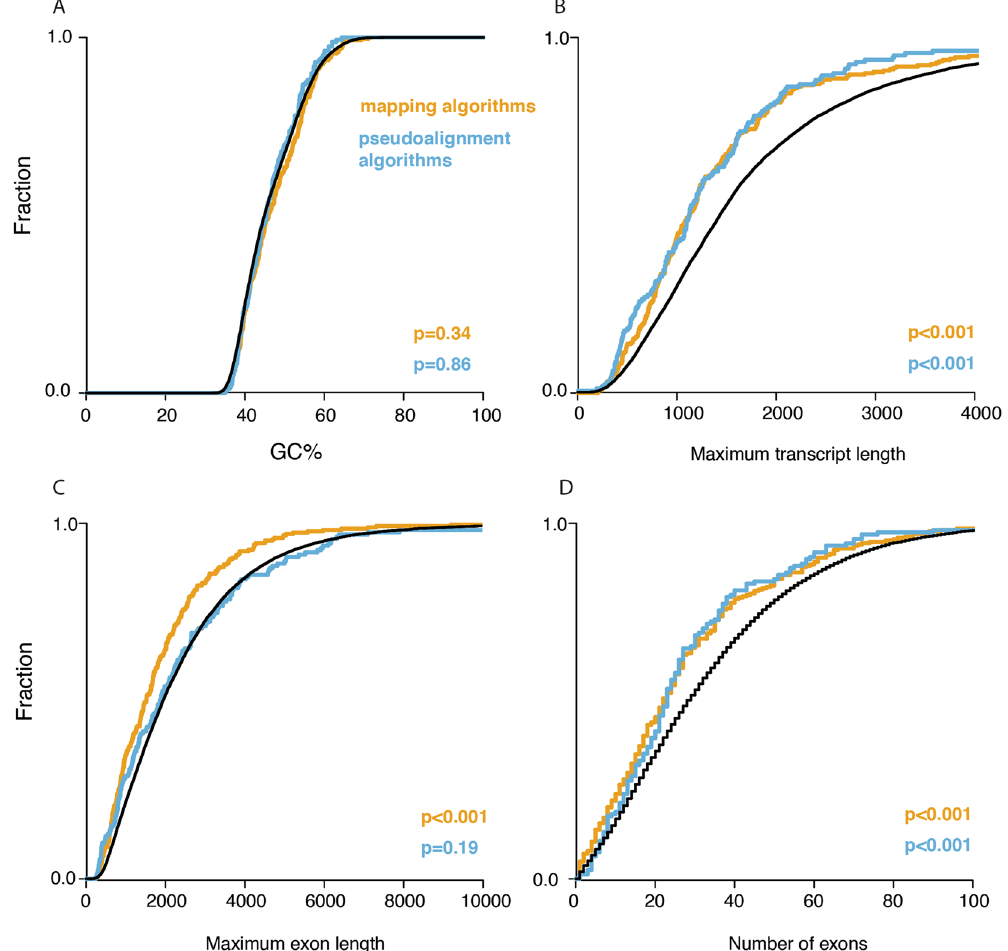
Figure 6. Non-concordant genes show differential characteristics compared to concordant genes. Cumulative fractions of %GC ( A ), maximum transcript length ( B ), maximum exon length ( C ) and number of exons ( D ) for concordant genes compared to non-concordant gens specific for either pseudoalignment or mapping algorithms. Kolmogorov-Smirnov p-values are